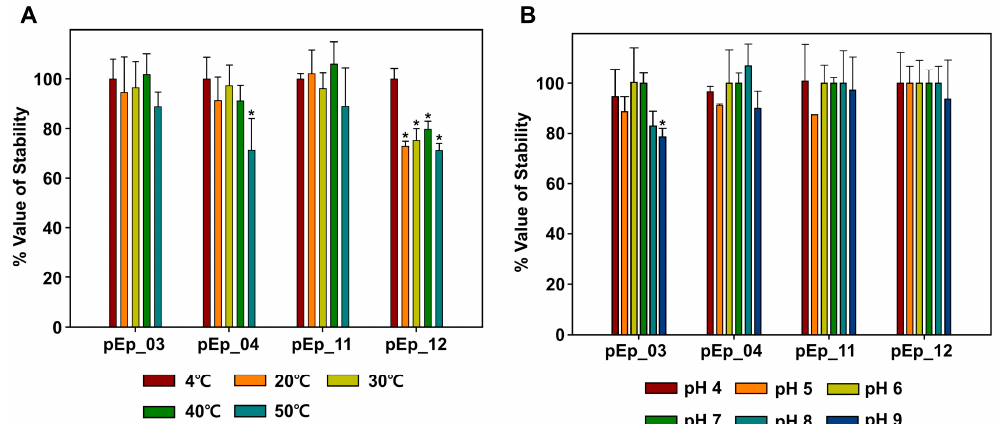
Figure 2. Stability of phages pEp_SNUABM_03, pEp_SNUABM_04, pEp_SNUABM_11, and pEp_SNUABM_12 at thermal ( A ) and pH ( B ) stresses. Phages were incubated for 1 h under each condition and the phage titer was determined on the host strain. One-way ANOVA with Holm–Sidak tests were performed to determine significant differences ( p < 0.05; n = 3).